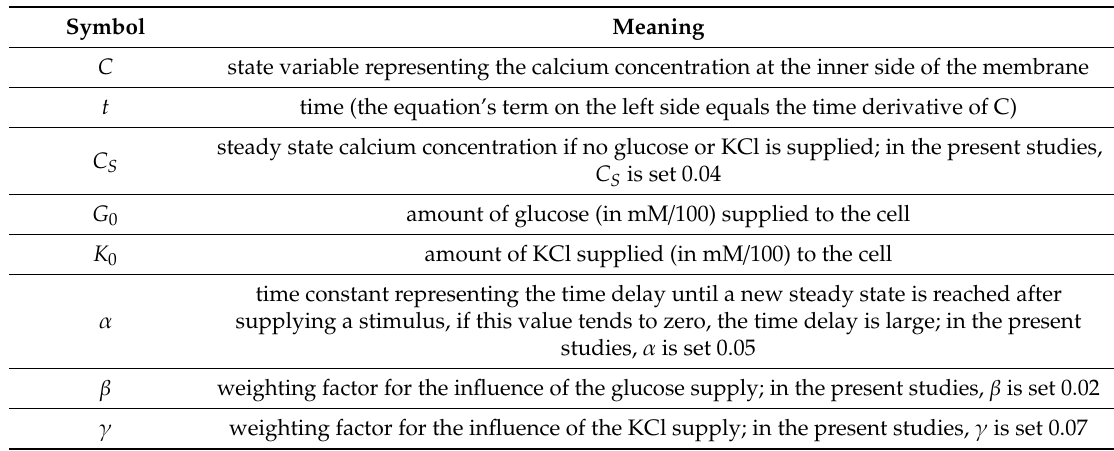
Table 4. Symbols in Equation (1) and their